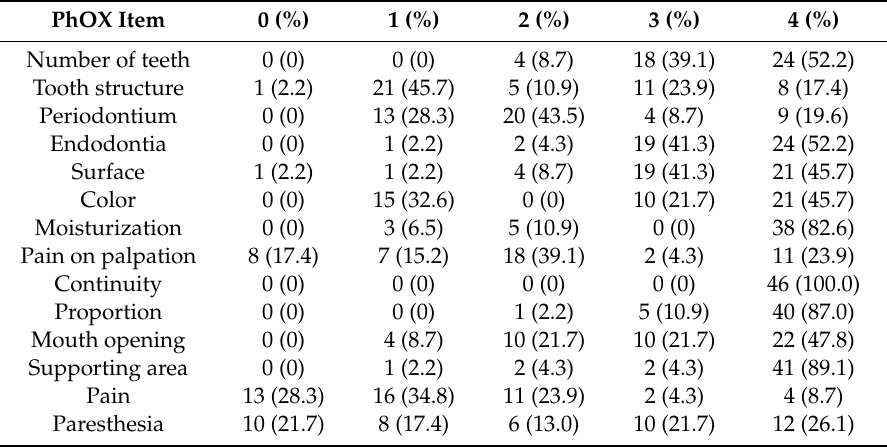
Table 5. Distribution of the individual 14 PhOX items among the